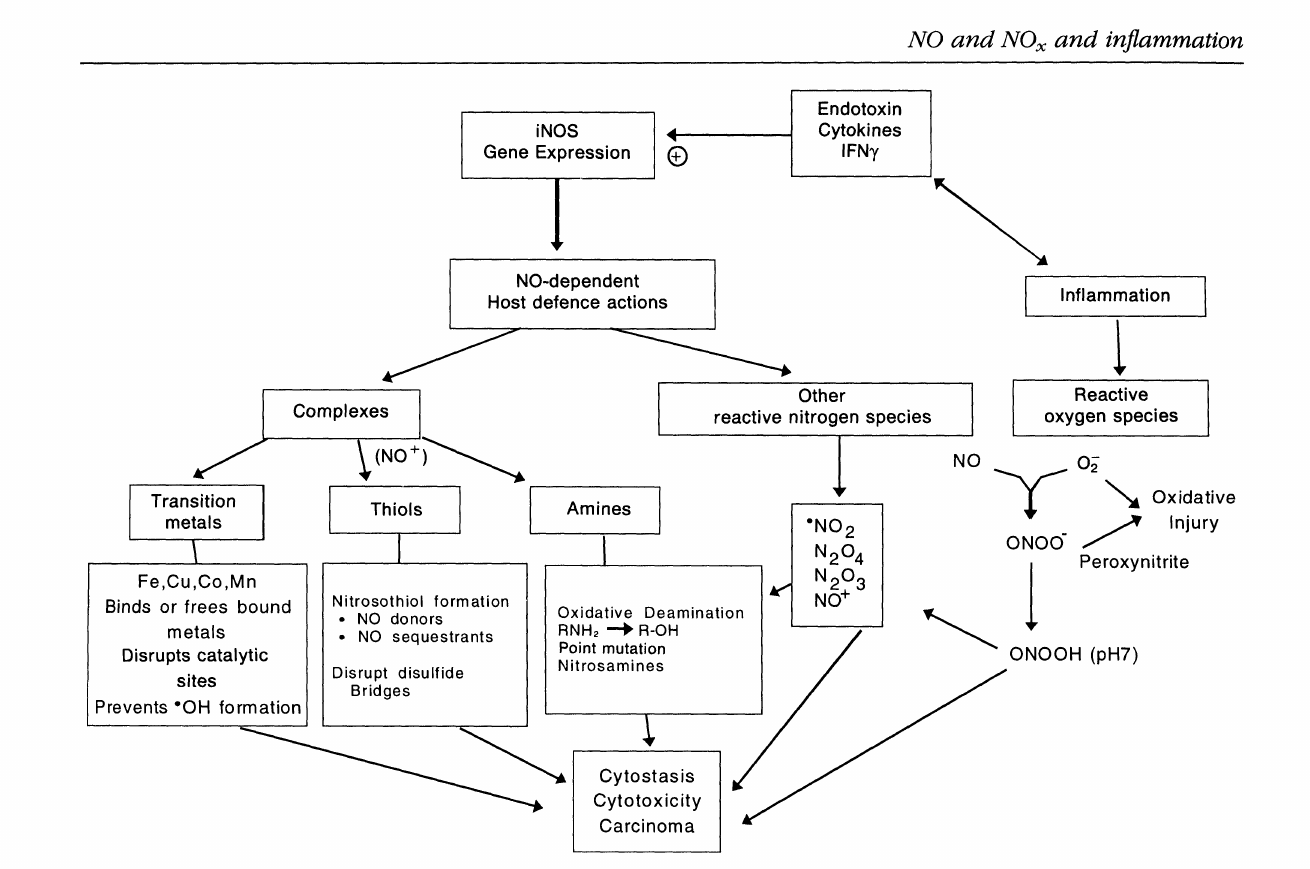
FIG. 1. Sites of action and interaction by nitric oxide in